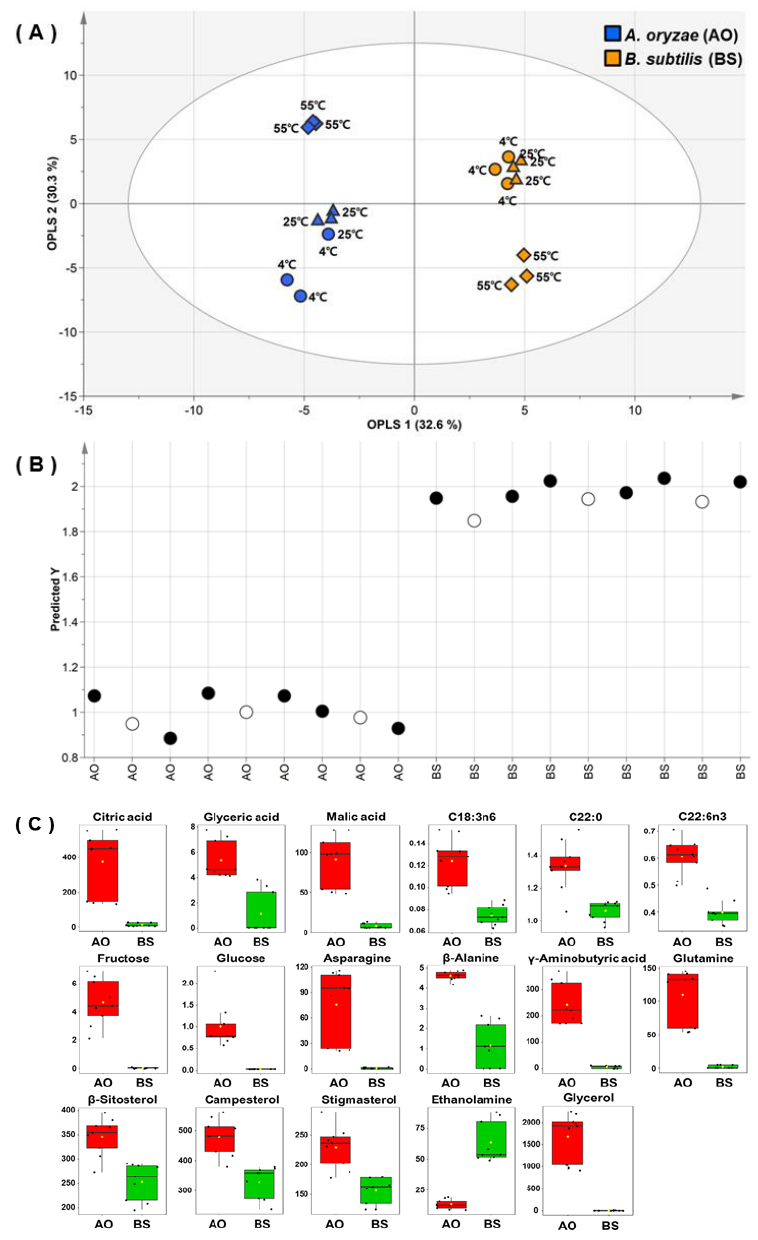
Figure 3. Orthogonal partial least squares discriminant analysis (OPLS-DA) score ( A ) and external validation test ( B ) plots for hydrophilic metabolite, lipophilic metabolite, fatty acid, isoflavone, and raffinose data obtained for soybeans fermented by Aspergillus oryzae (AO, blue symbols) or Bacillus subtilis (BS, yellow symbols) after water extraction at 4 ◦ C (circles), 25 ◦ C (diamonds), or 55 ◦ C (triangles). ( C ) Box plots of metabolites significantly different between AO- and BS-fermented soybeans. On the basis of variable importance in the projection >1.0 in the OPLS-DA model and the p < 0.0001 in the t -test for all metabolites, 17 metabolites were selected.